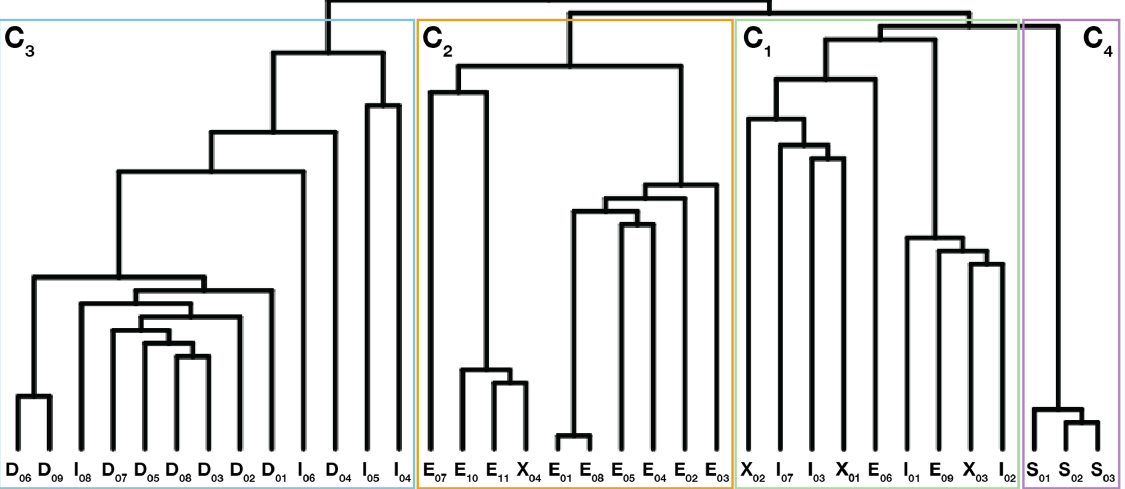
FIG. 4. The hierarchical structure of the partition provided by the fast-greedy cluster detection algorithm, represented as a dendrogram. Each node name is listed along the bottom. Each of the four clusters is identified by colored boxes around the respective branches; C